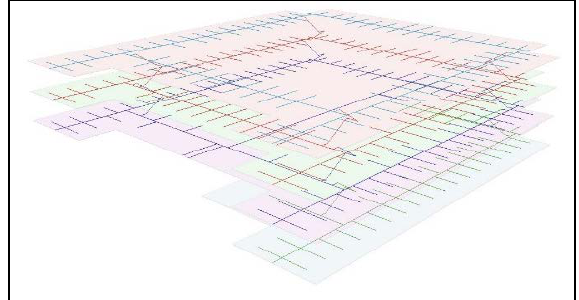
Figure 6. Kalayaan Dorm in three-dimensional